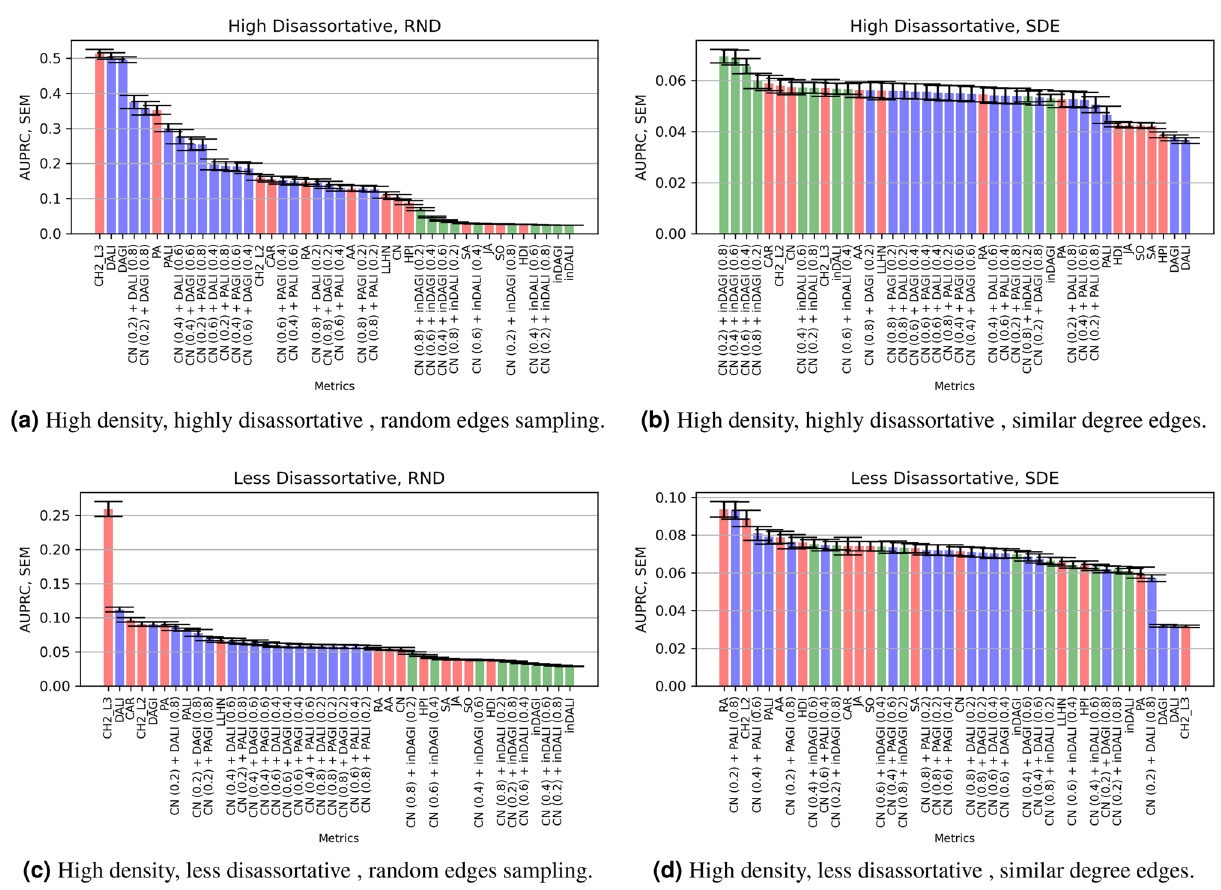
Figure 6. Performance of the LP models (i.e., the average AUPRC values) implemented on the high density, disassortative synthetic networks of size (100, 200, 250, 500, and 1000 nodes), 500 networks each. Table 2 depicts the high and less disassortativity coefficient r ranges, respectively. Red bars refer to standard LP models, blue bars refer to dissimilarity-based metrics along with their extensions and green bars refer to similarity-based metrics along with their extensions.